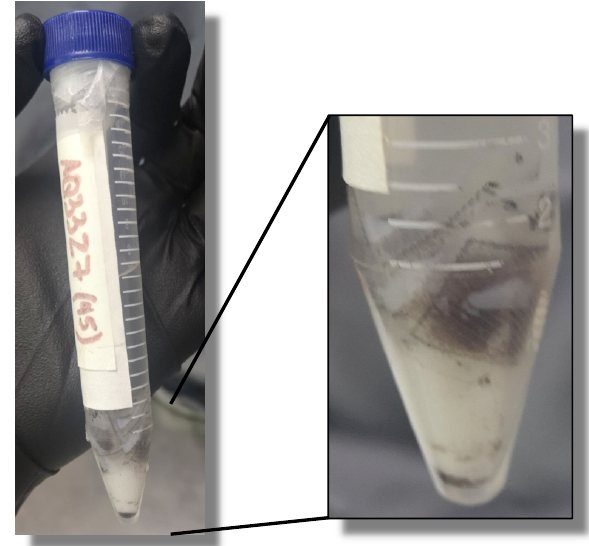
Figure 6. Peptide precipitation with ice-cold diethyl ether.